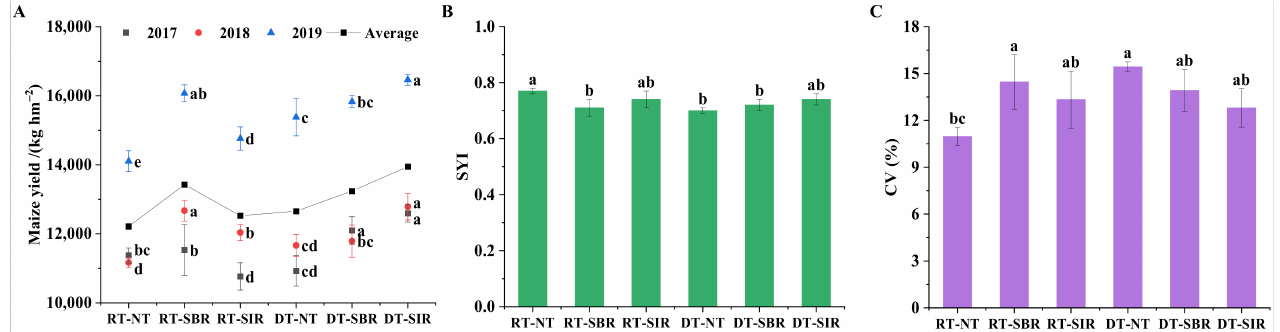
Figure 7. The maize yield ( A ), sustainability yield index (SYI, ( B )), and coefficient of variation (CV, ( C )) under different treatments. Different lowercase letters above the bars represent significant differences among treatments ( p < 0.05).